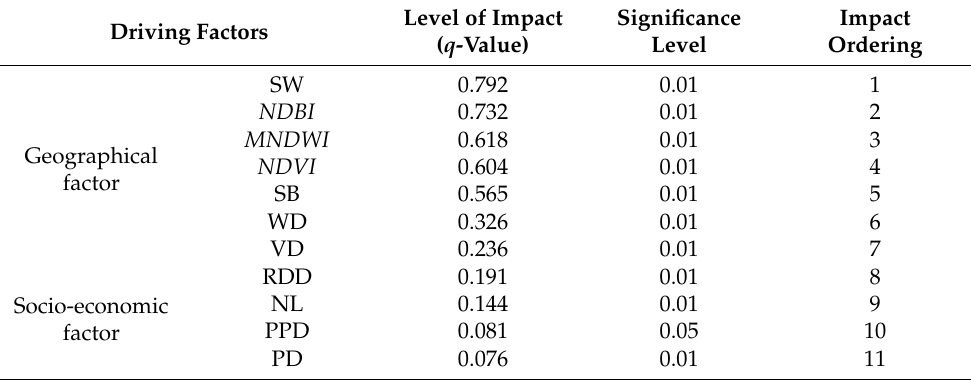
Table 2. Detection results of a single driving factor.